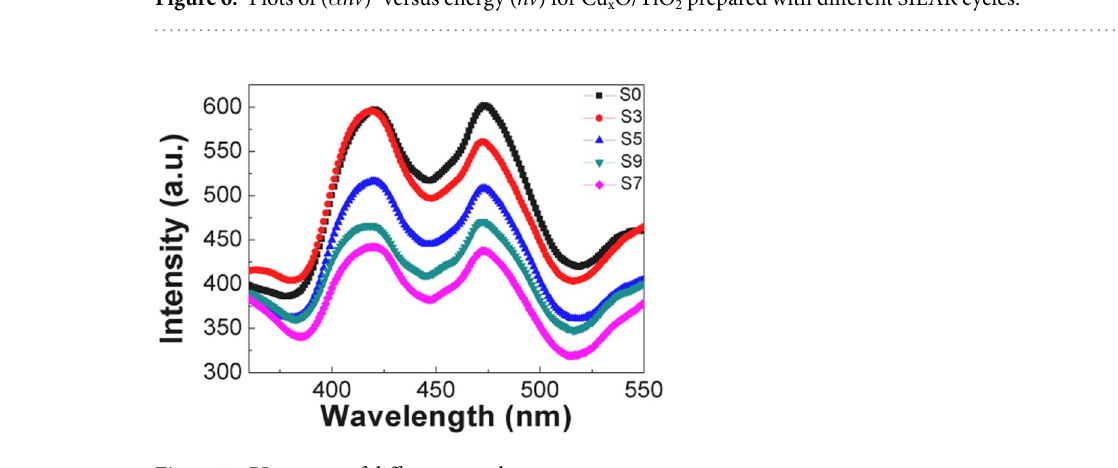
Figure 7. PL spectra of different